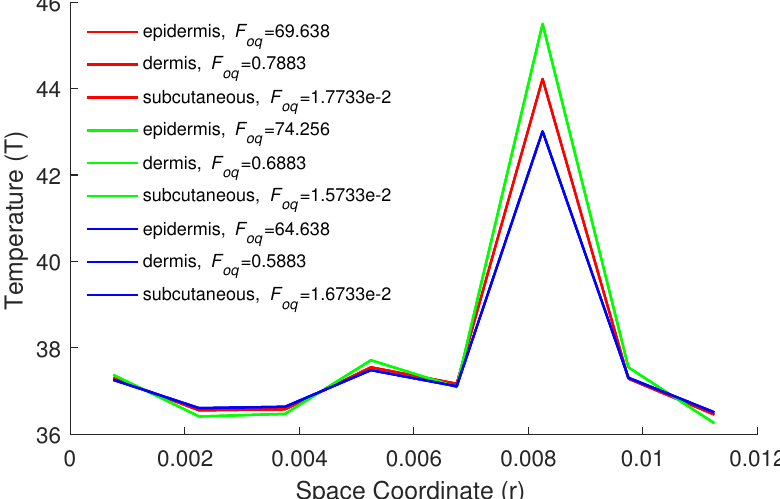
Figure 5. Temperature distributions for different values of F oq and F ot = 1.741 × 10 − 2 , 0.05631, and 1.267 × 10 − 2